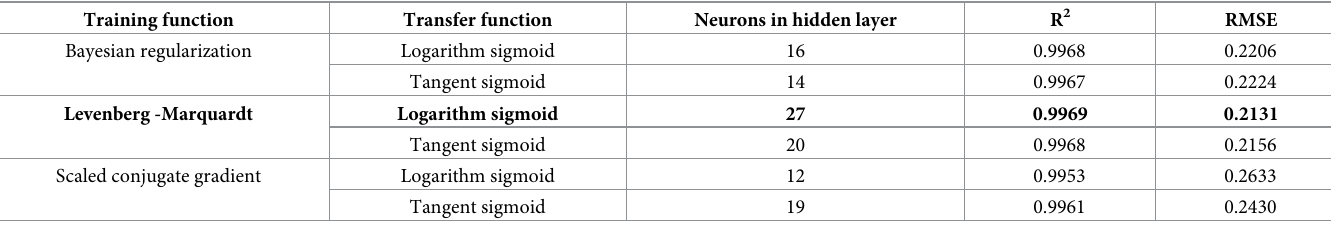
Table 8. The most accurate ANN models trained with 2021 data for estimation of LA based on leaf length and width. Training function